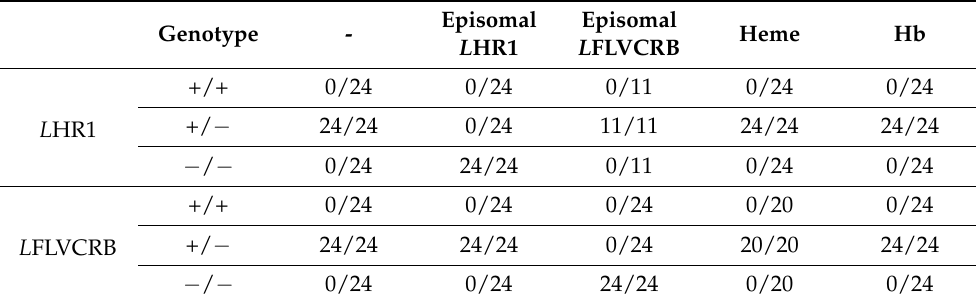
Table 1. L HR1 and L FLVCRB are essential in L. major promastigotes. Attempts to delete both genes from the L. major genome using the CRISPR-Cas9ool kit [27]. Data show the number of clones of each genotype (wt, +/+; single knockout, +/ − ; double knockout − / − ), analyzed as described in Material and Methods, obtained after transfection of parasites with or without an episomal copy of the indicated gene, or in cultured medium supplemented with 10 µ M heme or 2.5 µ M